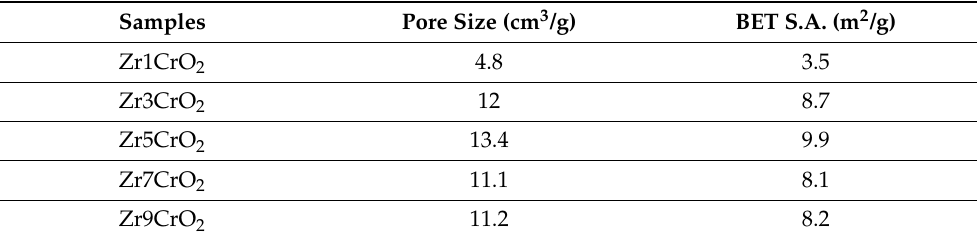
Table 3. BET analysis of Zr-doped CrO 2